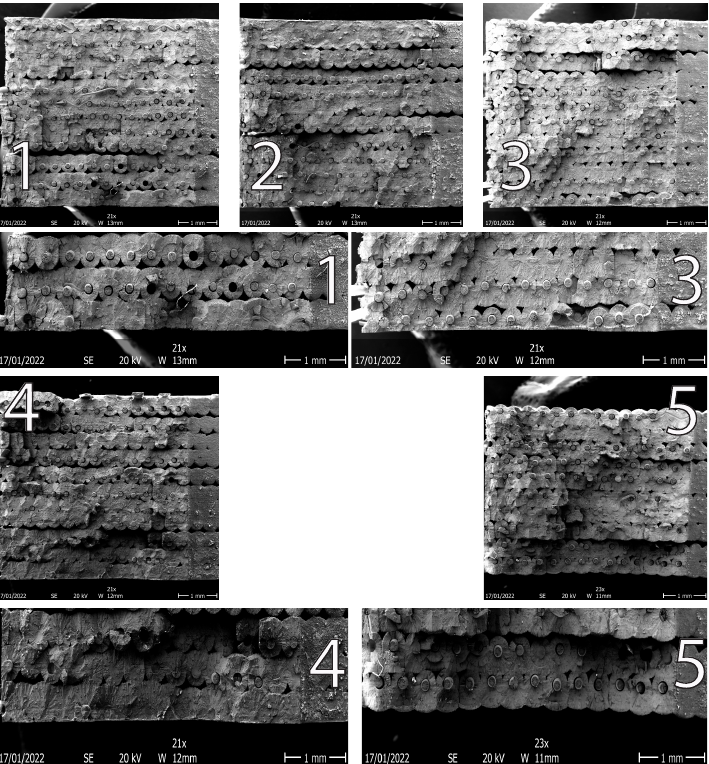
Figure 14. Pictures of the fracture surface of the individual medium-sized samples (numbers indicated sample name), the closeups highlight the good ductile failure of the fibres in some cases and the brittle nature in others.